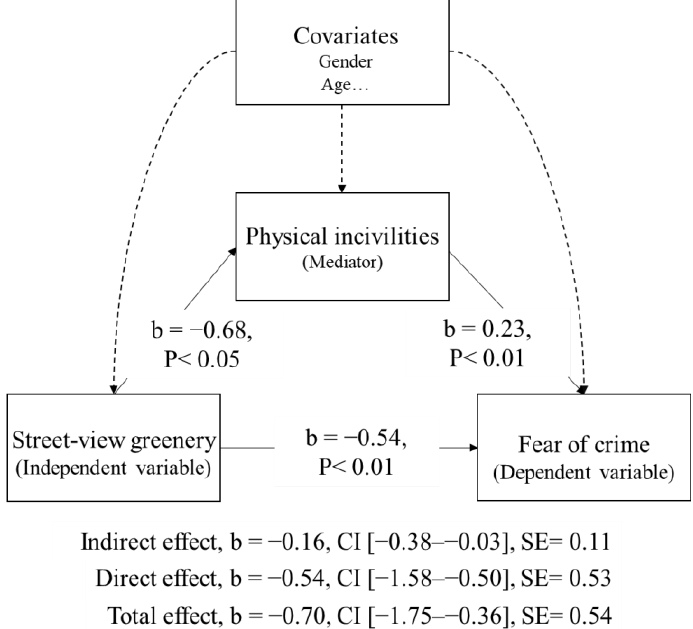
Figure 6. Mediation model of street-view greenery as a predictor of fear of crime, mediated by physical incivilities (b is an unstandardized regression coefficient, and CI is the confidence interval for the bootstrap approaches between BootLLCI and BootULCI).